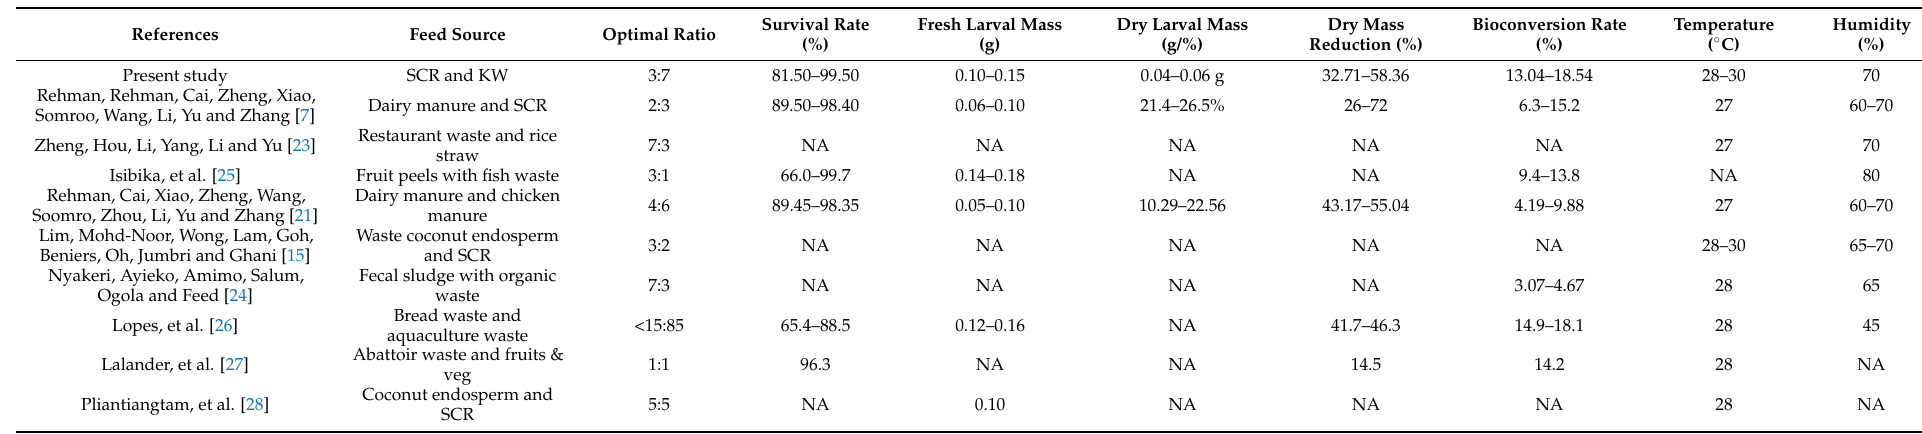
Table 1. Comparison of selected parameters of black soldier fly conversion